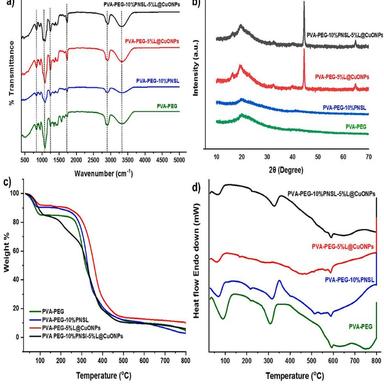
Characterization and thermal stability of PVA-PEG, PVA-PEG-10%PNSL, PVA-PEG-5%L@CuONPs, PVA-PEG-10%PNSL-5%L@CuONPs nanocomposite films; a) FTIR spectrum; b) XRD analysis; c) TGA analysis; and d) DSC analysis.